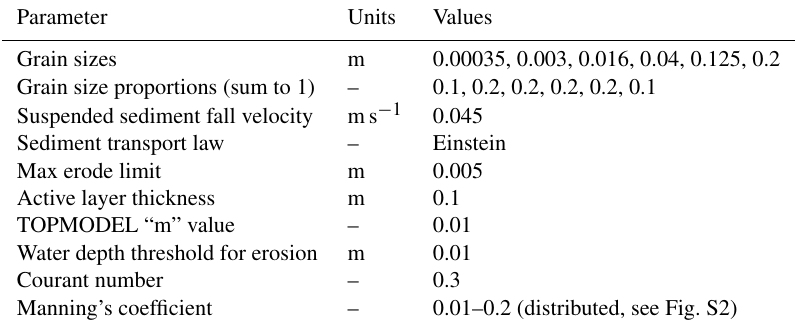
Table 3. Parameters of the CAESAR-Lisflood model.